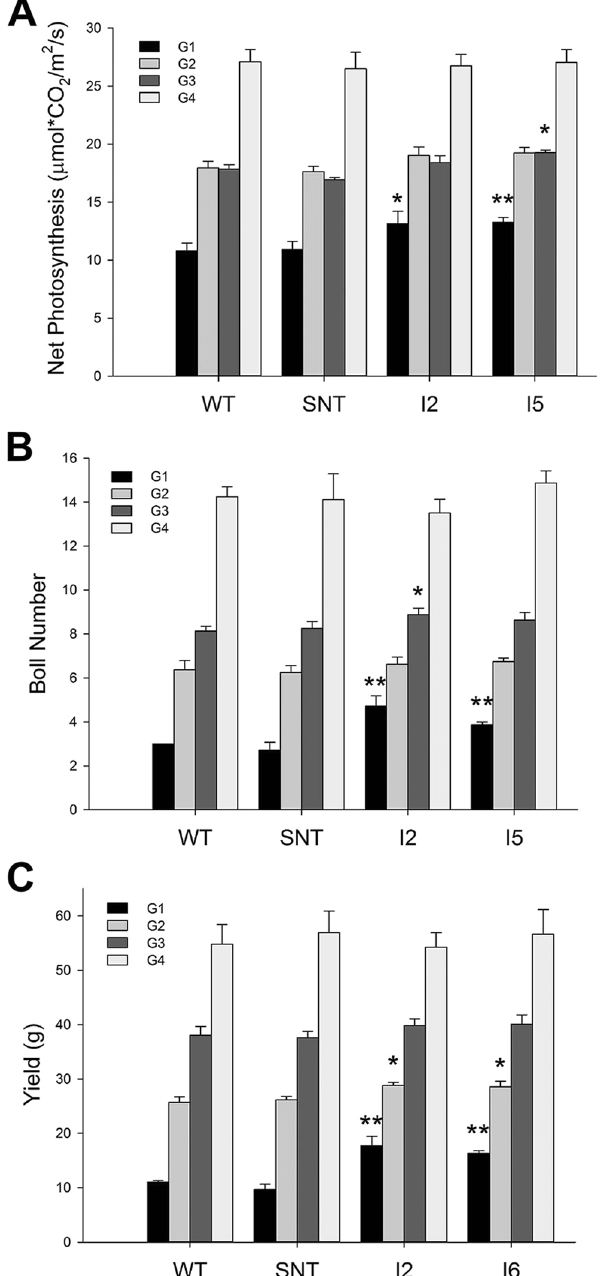
Figure 6. Photosynthetic rate, boll number and cotton seed yield of cotton lines under differential irrigation conditions in greenhouse. WT, wild-type cotton (Coker 312); SNT, segregated non-transgenic cotton; IPT2 to IPT9, four independent IPT -transgenic cotton